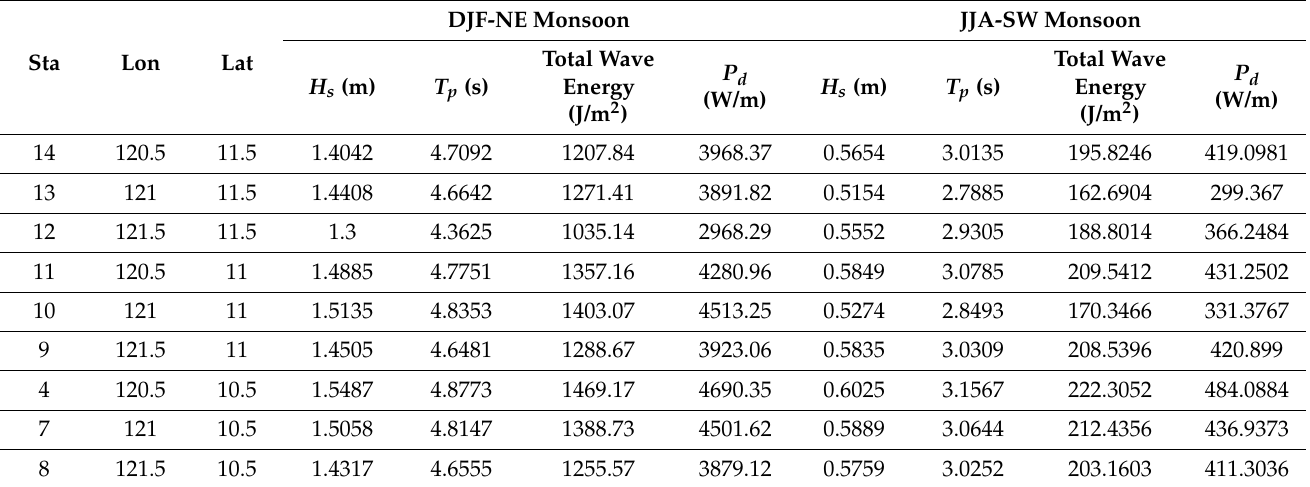
Table 5. Summary results of wave parameters for the NE and SW monsoons at the nine (9) MOV stations.